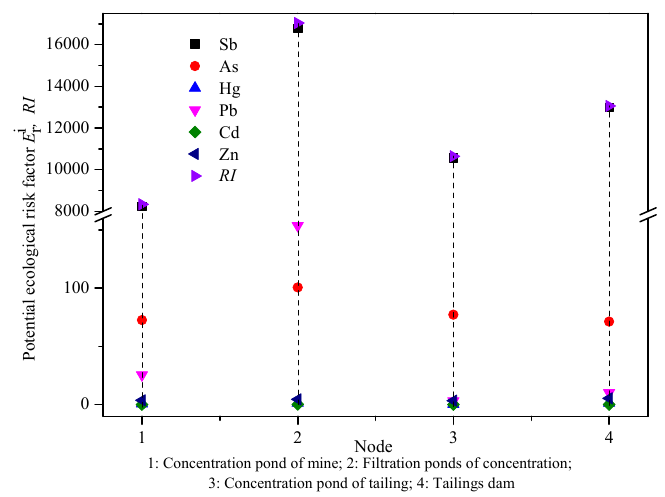
Figure 2. Evaluating results by individual E ir and compound RI .